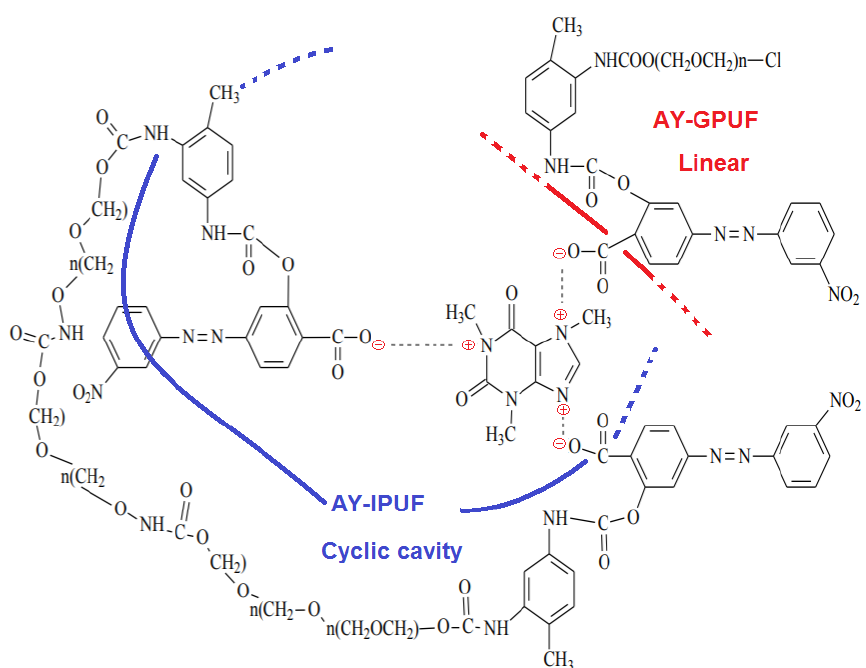
FIGURE 8 - The proposed structure of sorbents, and the mechanism of adsorption by the AY-GPUF and